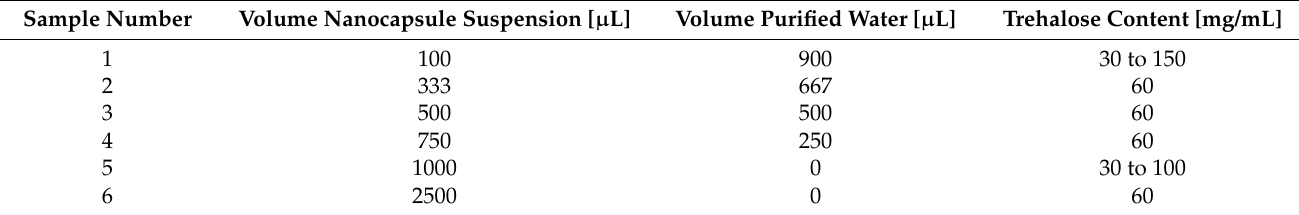
Table 1. Overview of the tested nanocapsule batches under